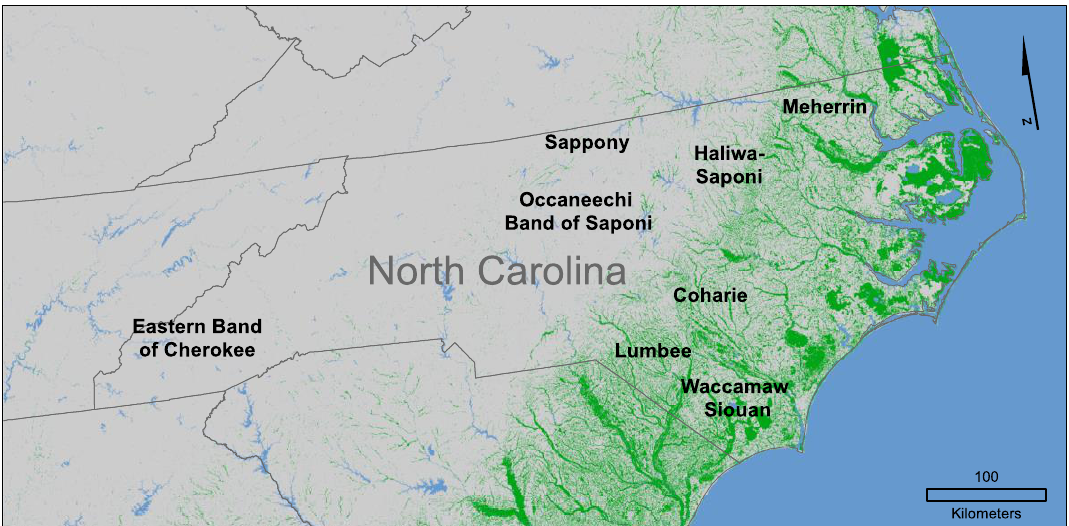
Figure 1. Tribal nations in present-day North Carolina. Names indicate approximate extent of present-day territories. Wetlands (green) and inland water bodies (blue) are adapted from the 2016 National Land Cover Dataset.